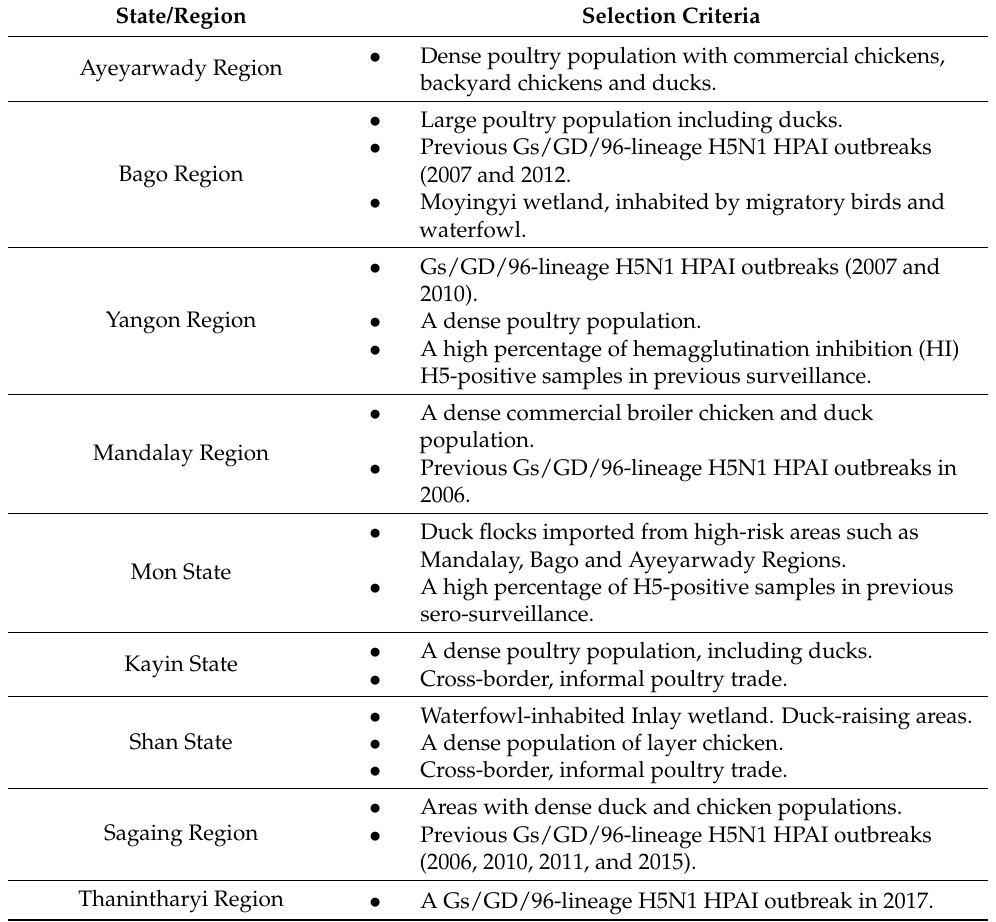
Table 1. Criteria used for selecting states/regions for sero-surveillance in Myanmar.